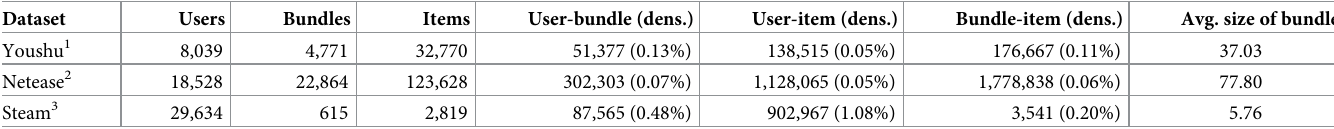
Table 2. Summary of